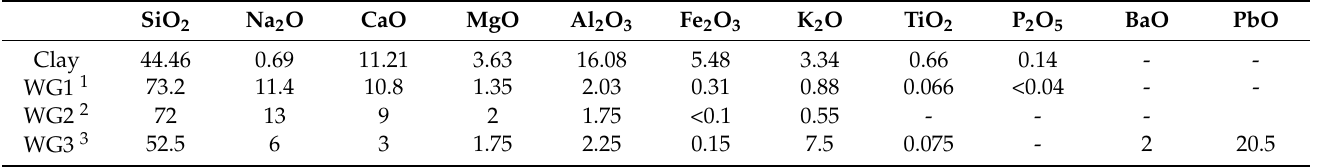
Table 2. Average chemical composition in wt.% of WG and clay obtained from FRX analysis. Please note that they are average values and do not necessarily add up to 100% for each element.